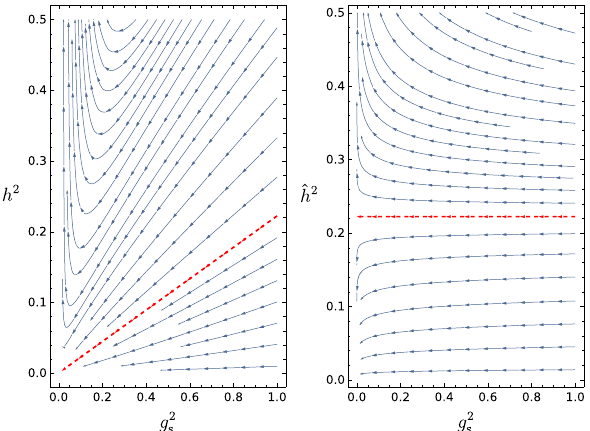
Fig. 1 Left Panel the one-loop RG flow of the perturbatively renor- malizable model projected on the plane of the Yukawa coupling h 2 and the strong gauge coupling g 2 s . The color and flavor numbers are fixed to N c = 3 and N f = 6. Right panel the same flow plotted in terms of the rescaled Yukawa coupling ˆ h 2 defined in Eq. (4). The UV repulsive QFP is highlighted by a red dashed line that corresponds to the solution of Eq.